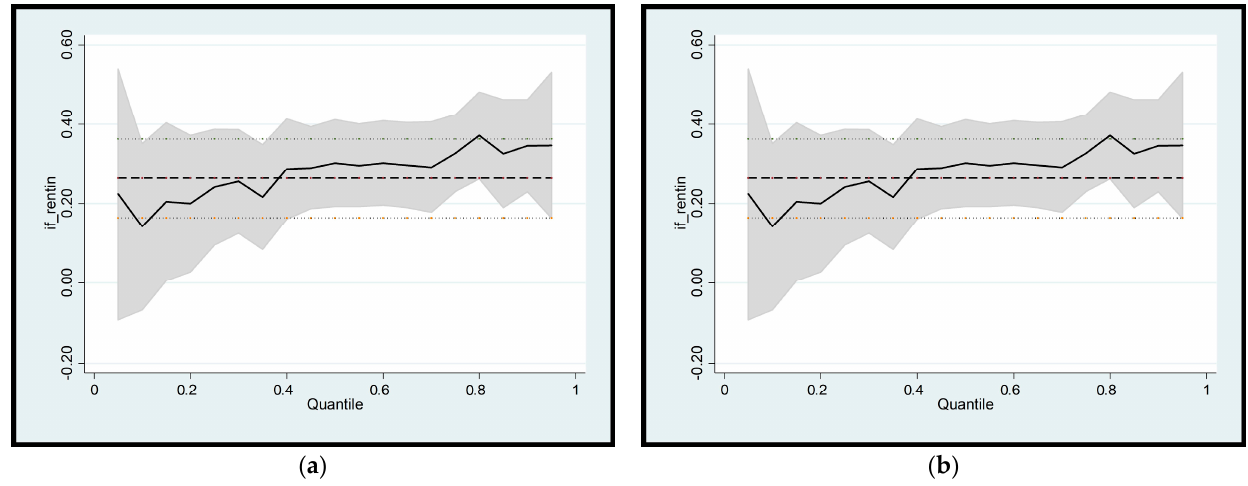
Figure 4. The effects of farmland renting in ( a )/renting out ( b ) on household on-farm income across quantiles.